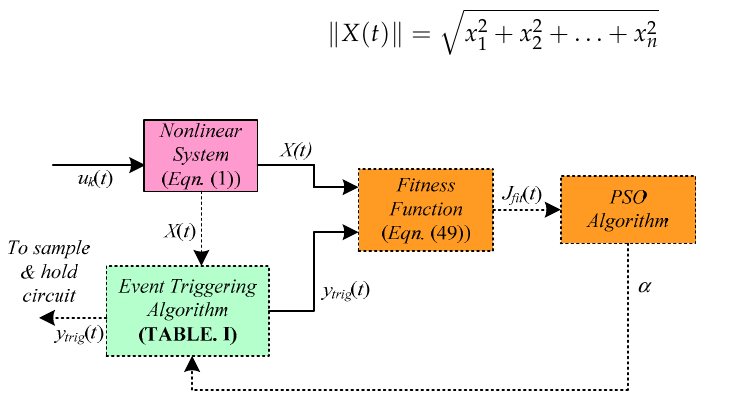
Figure 2. Block diagram for optimizing triggering parameter α based on PSO (offline tuning). The y trig ( t ) , represents the triggering pulses which actually drive the sample and hold circuit. The y trig always toggles between 0 and 1. The y trig ( t ) = 1 means that the switches in AS and ZOH blocks (in Figure 1) are closed, whereas the switches are opened for y trig ( t ) =